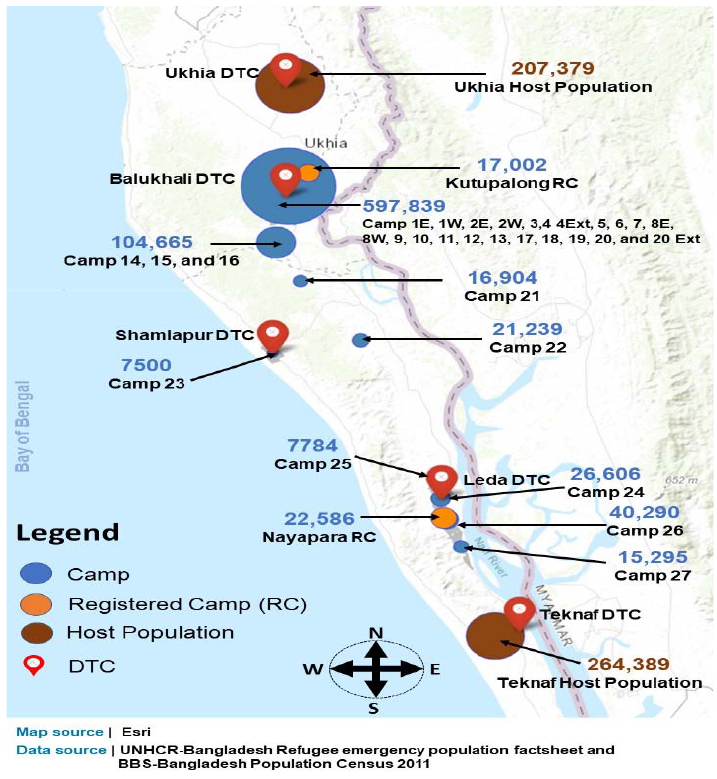
Table 1. Description and capacities of the DTCs.